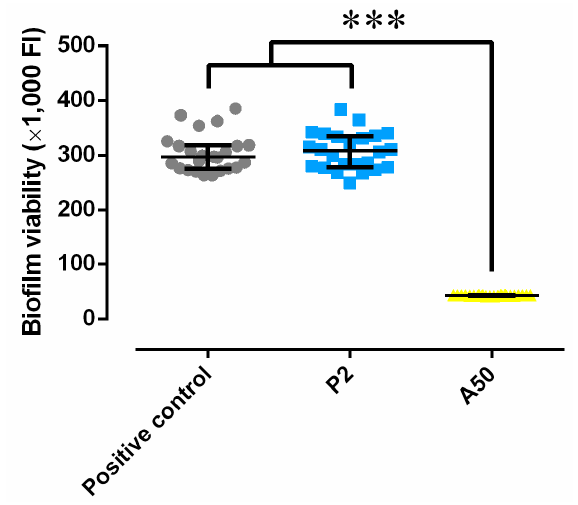
Figure 3. Biofilm viability of S. epidermidis ATCC35984 developed in the presence of sol-gel without antibiotic (P2) and of moxifloxacin-loaded sol-gel (A50). ***: p -value < 0.001 for Wilcoxon test between the groups compared.